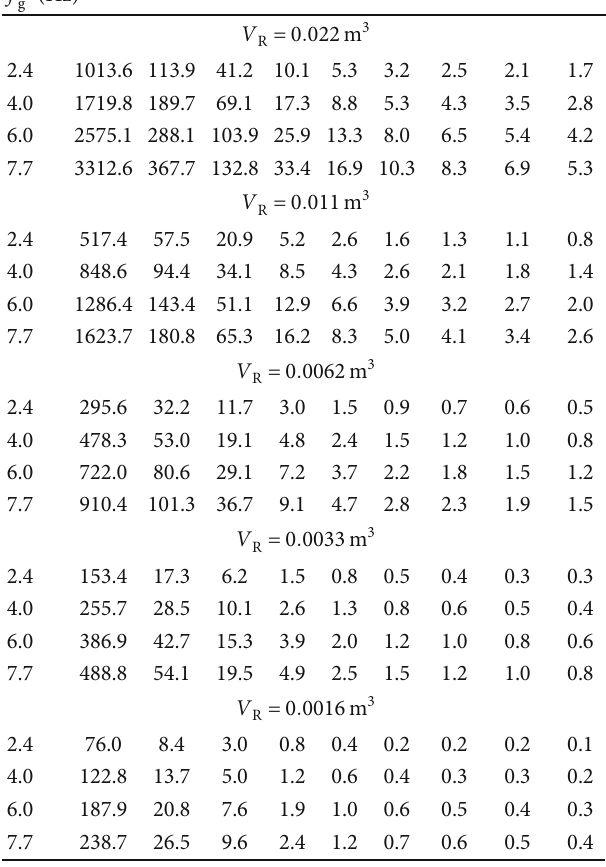
Table 3: Variation of K E as a function of the nominal gust , vent hole radius, R frequency, f N g reservoir, V R